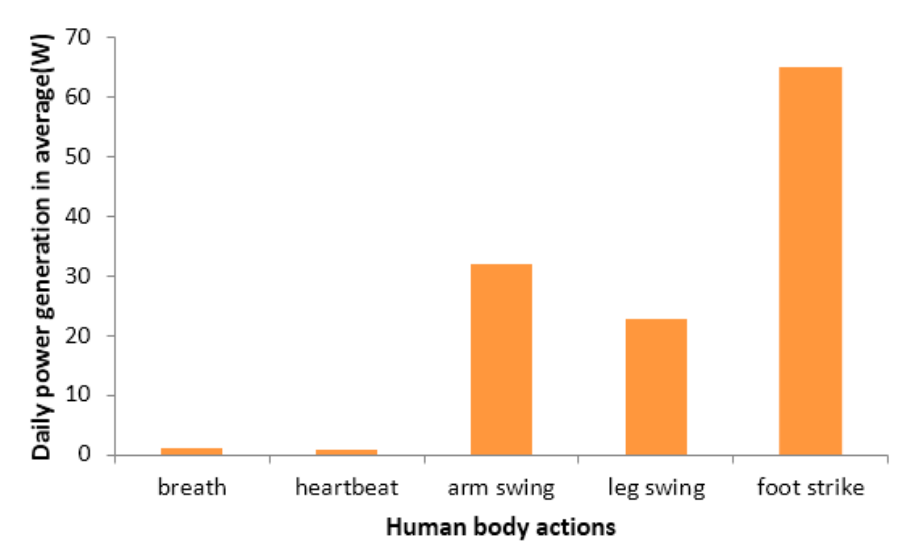
Figure 1. Energy generated by typical types of human movements.